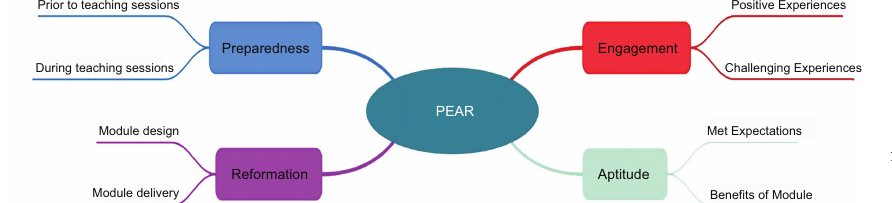
Figure 1. Interview